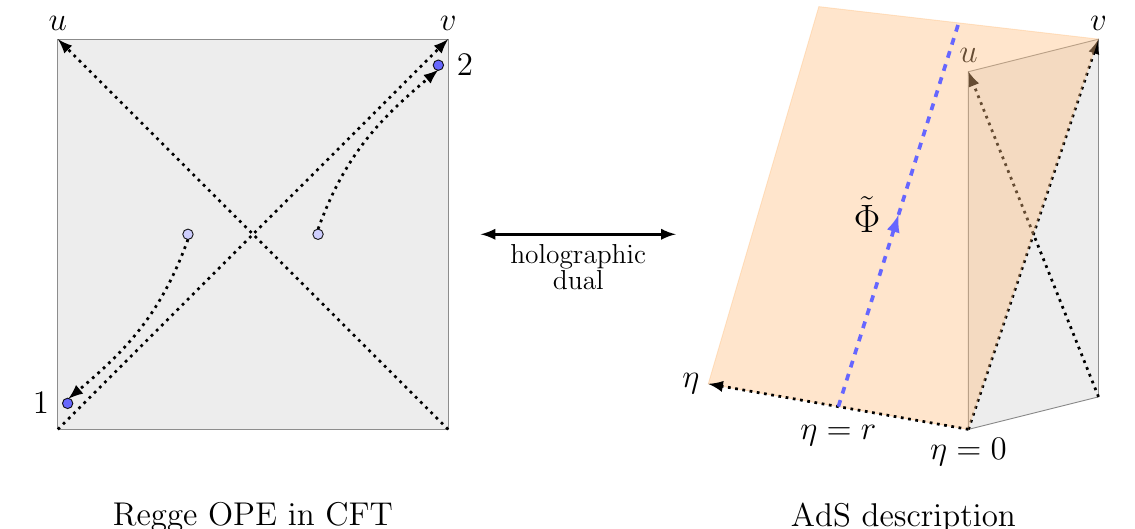
Figure 7 . [Left] The Regge OPE of two local scalars O 1 ( x 1 ) O 2 ( x 2 ) in CFT. [Right] The holo- graphic description as a bulk operator smeared in the v direction at (cid:12)xed radial coordinate (cid:17) = r . It can be interpreted as a bulk shockwave geometry when (cid:1) = d; J = 2 [19]. Our argument is